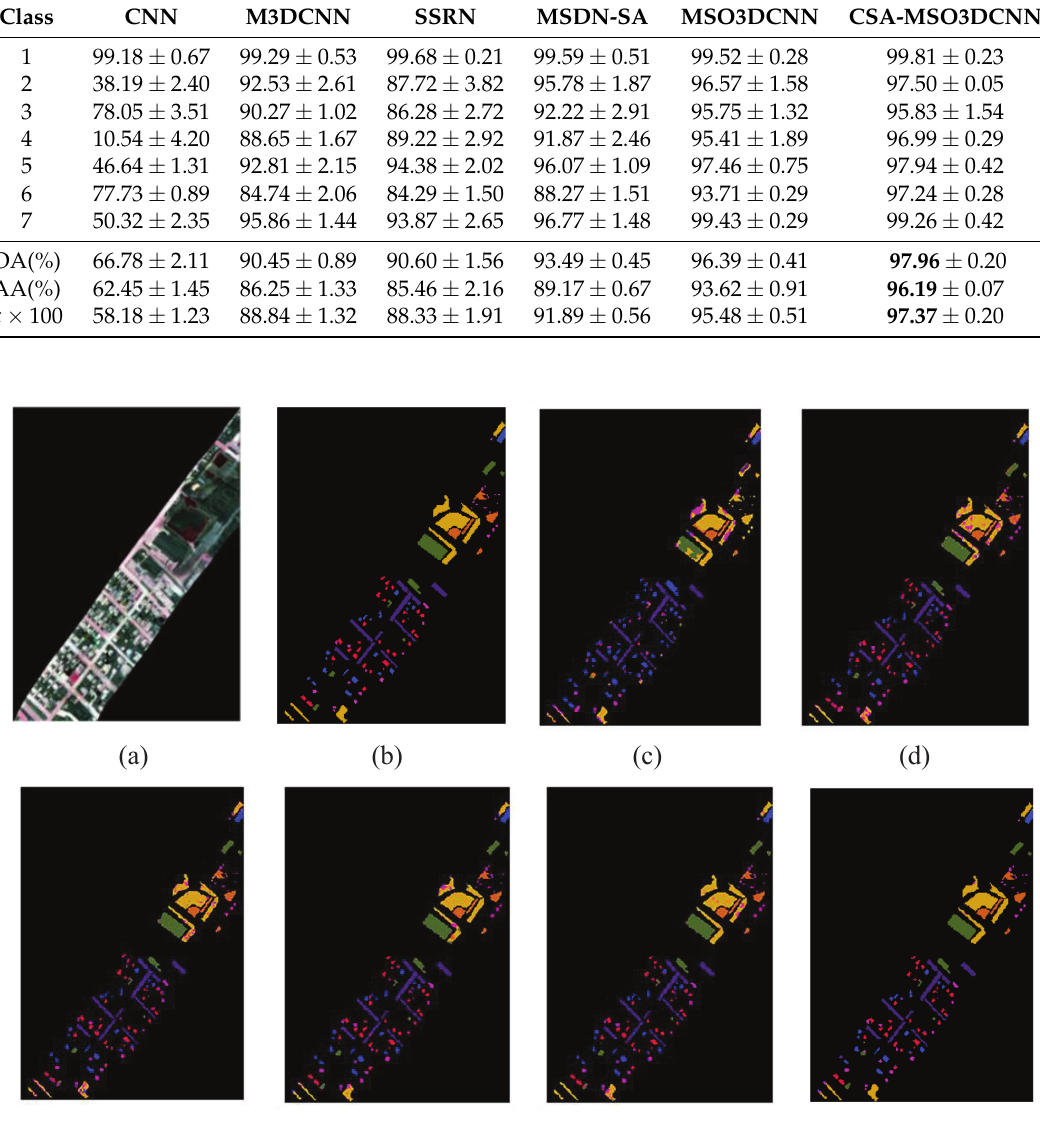
Table 8. Classification accuracy for the Grss_dfc_2014 data set.